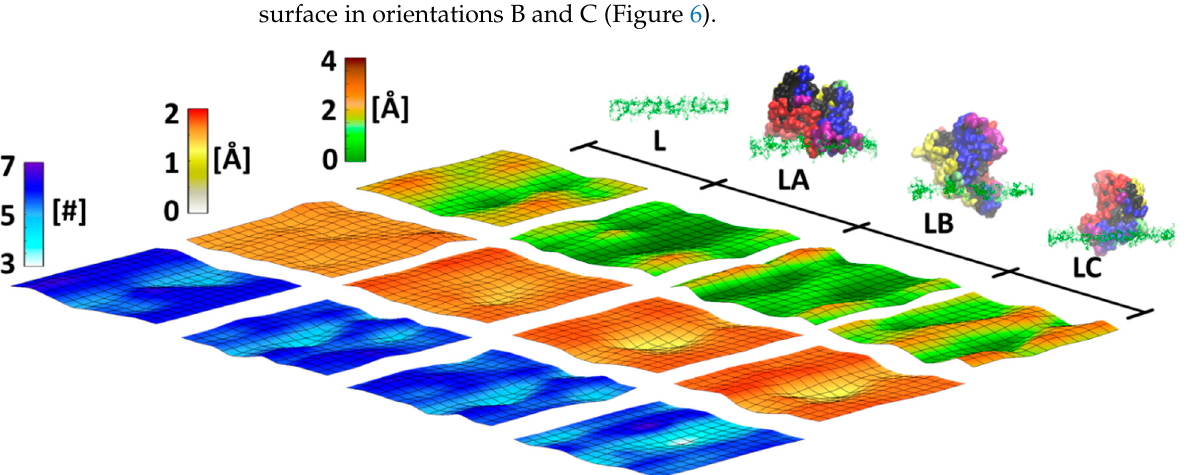
Figure 6. The averaged topology heights of the polymer chains (top), the RMSF of the polymer chains (middle), and the water hydration of the polymer chains (bottom) i.e., number of water molecules around the polymer chains, at low ‐ density surface in the absence of a foulant (model L, left), and in the presence of the BSA foulant at three orientations: models LA, LB, and LC (see Figure 2 for details about the different models). The final simulated snapshots are illustrated for each model.